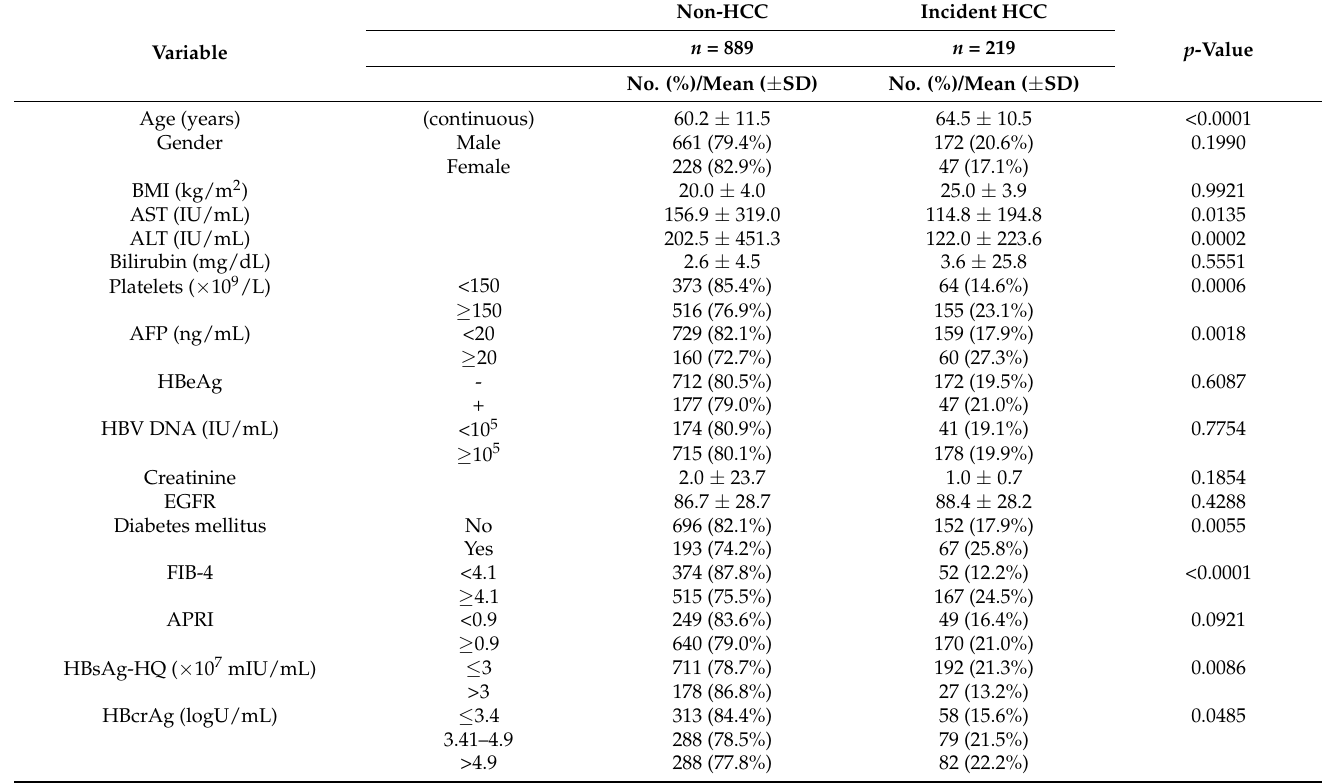
Table 1. Characteristics of hepatocellular carcinoma development in chronic hepatitis B patients with liver cirrhosis and complete virological suppression.